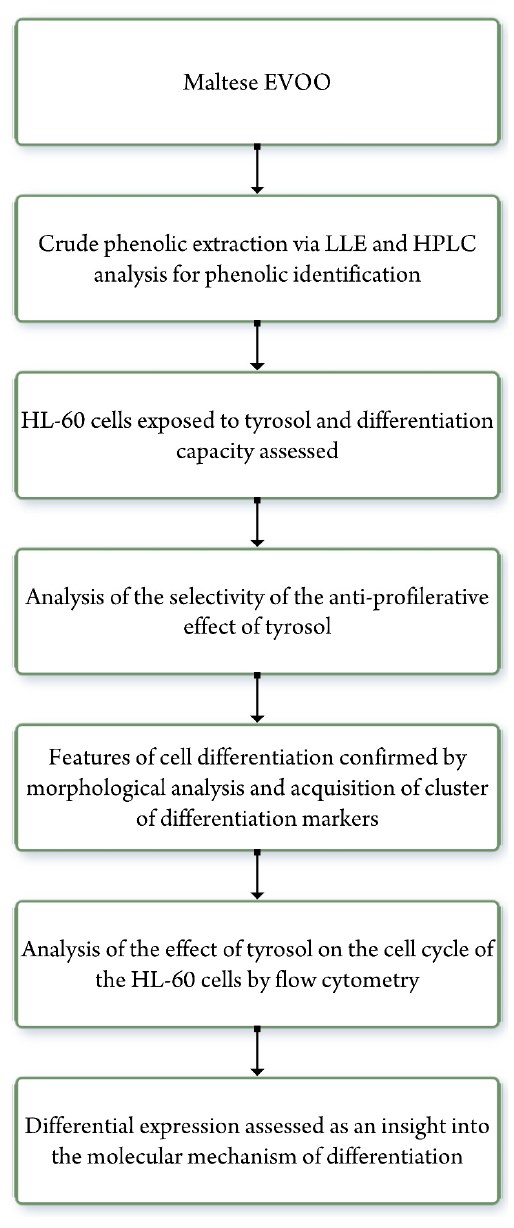
Figure 1. The design of the